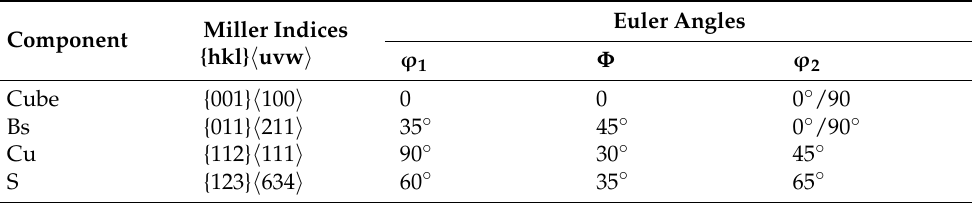
Table 6. Euler angles of Ideal texture components “ β -fiber” according to [39].